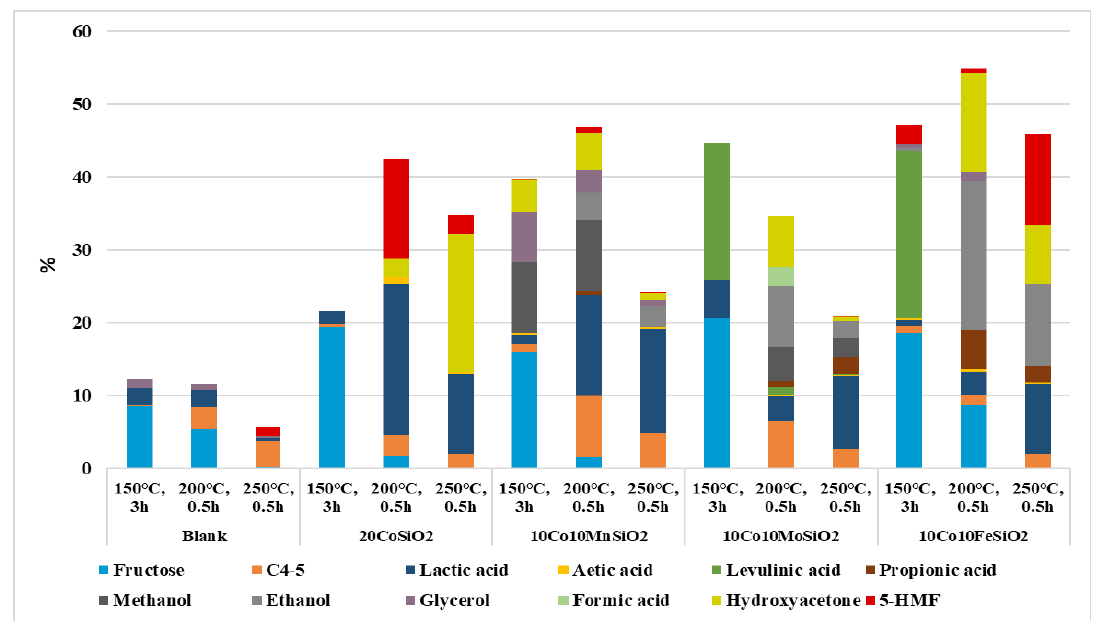
Figure 6. Product distribution for the transformation of glucose in the presence of catalysts.